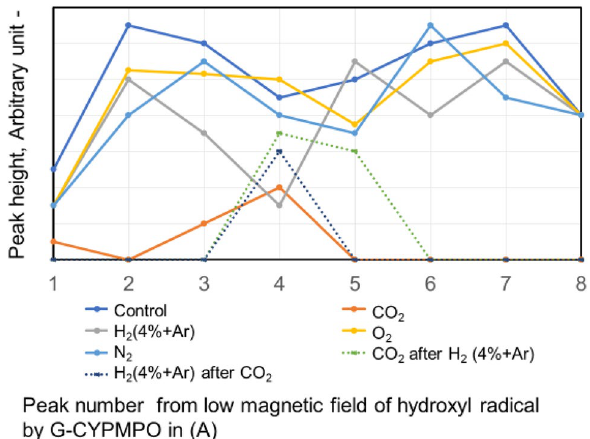
Figure 2. Comparison between different kinds of gas nanobubble peak height of peak number from low magnetic field shown in (A) of Fig. 1 of hydroxyl radical by G-CYPMP.